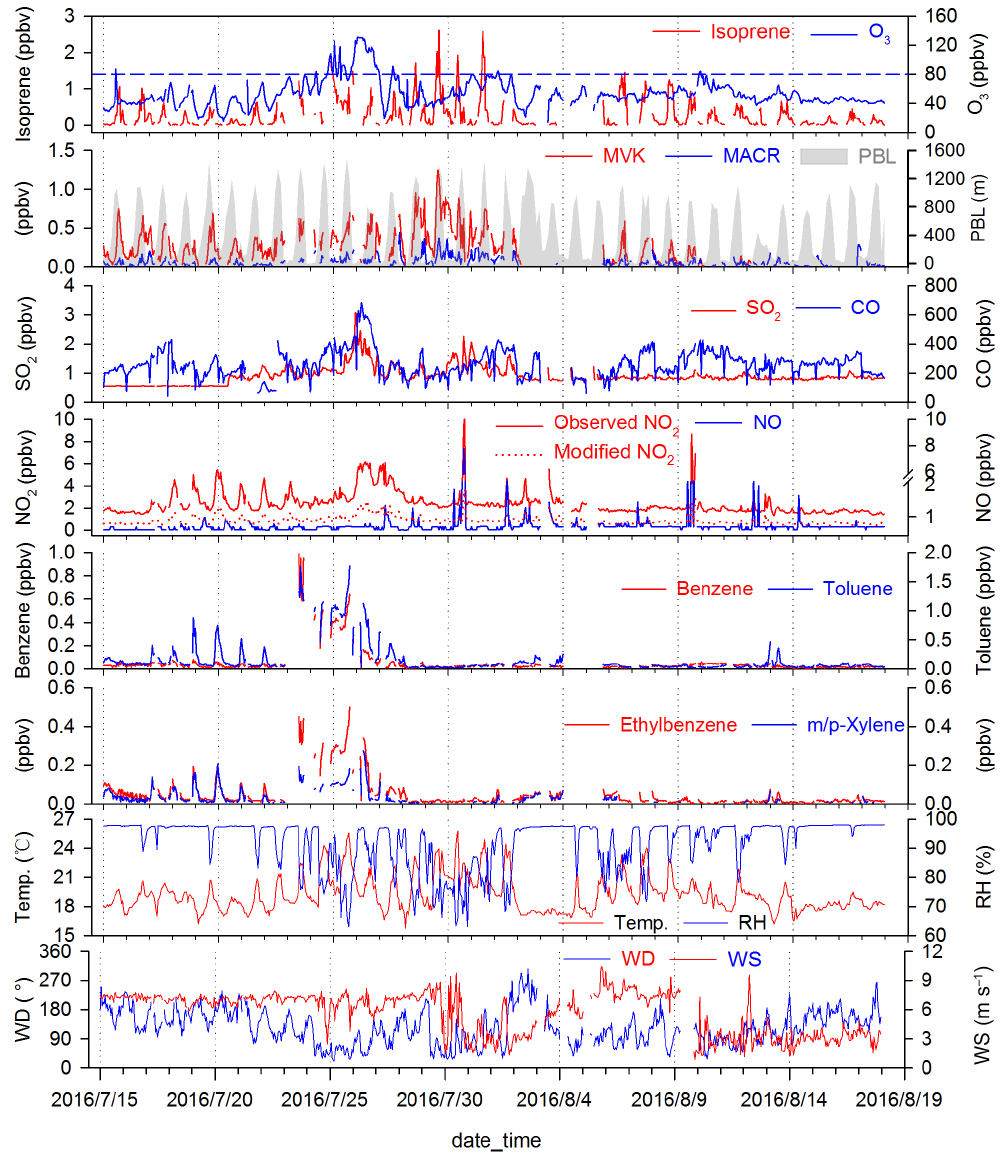
Figure 2. Time series (1h data) of trace gases, meteorological parameters and the planetary boundary layer (PBL) height (PBL data provided by Real-time Environmental Applications and Display sYstem, https://ready.arl.noaa.gov/READYamet.php, last access: 14 July 2018) during 15 July–17 August 2016 at the Nanling site. Modified NO 2 defined here as the product of modification factor (Fig. S1) and observed NO 2 . Blue dashed lines are Grade I of the ambient air quality standard in China for O 3 (80ppbv). Temperature, relative humidity, wind speed and wind direction are referred to as Temp., RH, WS and WD,